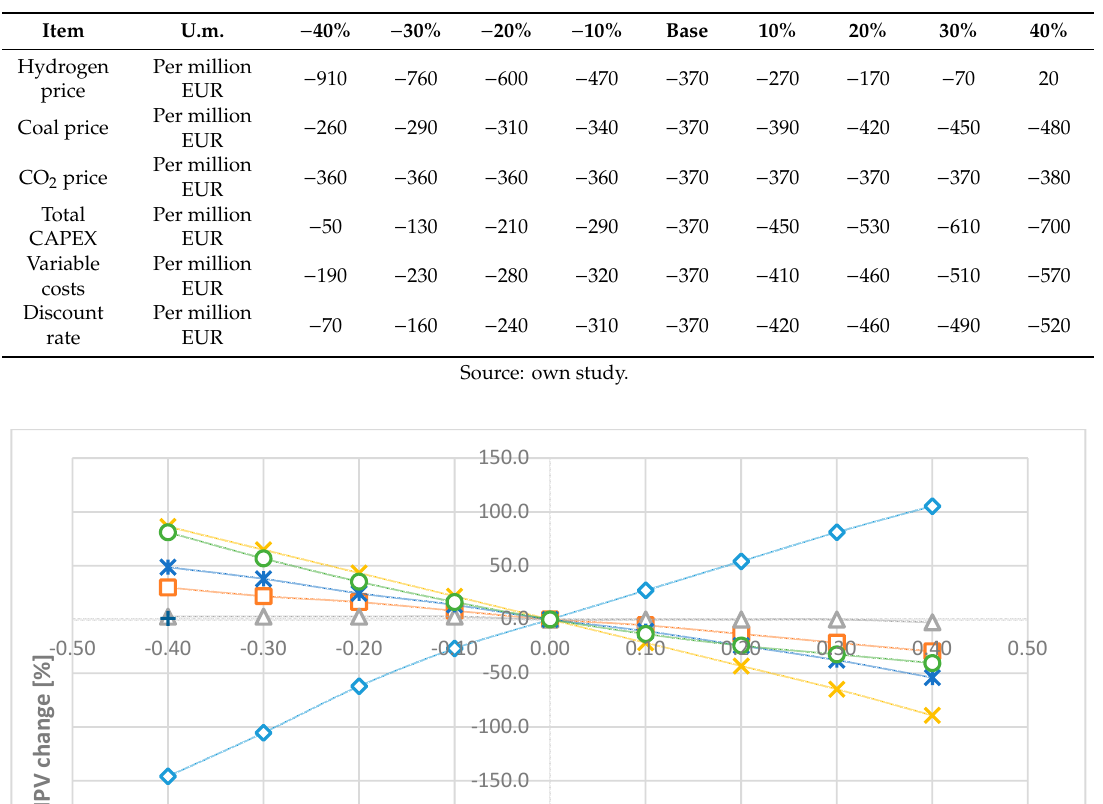
Table 10. Sensitivity analysis for hard coal gasification w / CCS (HC_H2_1).